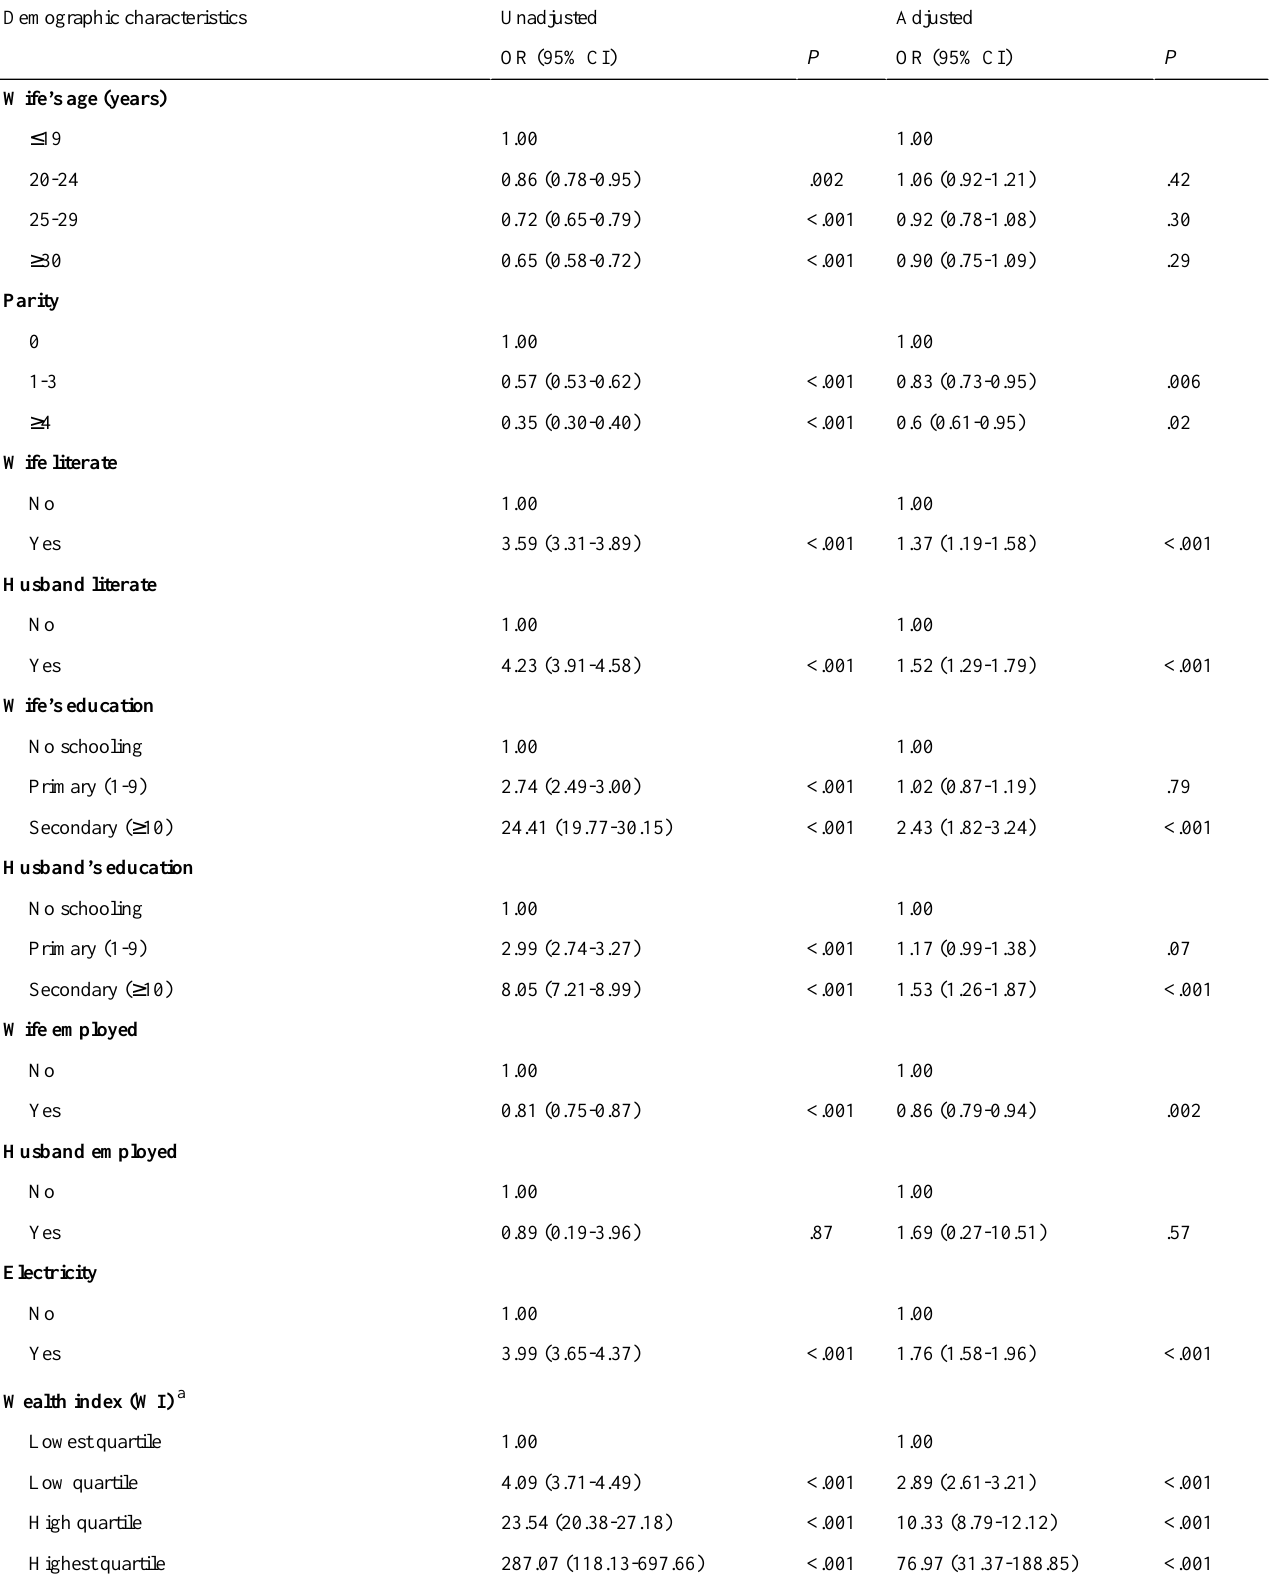
Table 5. Unadjusted and adjusted odds ratio (OR) and 95% confidence intervals (95% CI) of reporting household mobile phone ownership by demographics for fiscal year 2 (n=12,132), July 2009-June